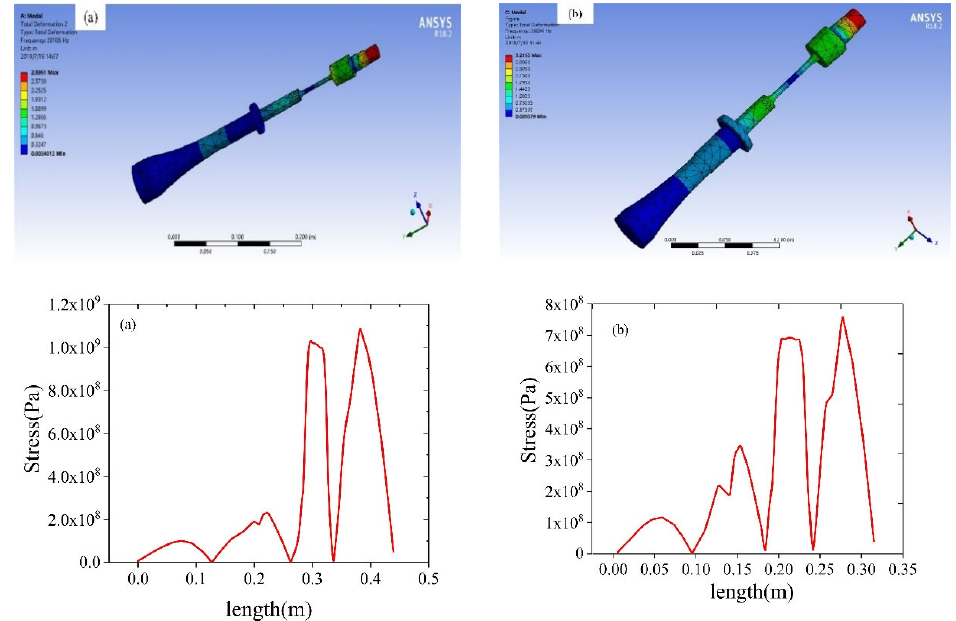
Figure 5. Simulation analysis of the ultrasonic vibration tensile resonance system ( a ) 20 KHz; ( b ) 28 Figure5. Simulationanalysisoftheultrasonicvibrationtensileresonancesystem( a )20KHz; ( b ) 28 KHz.